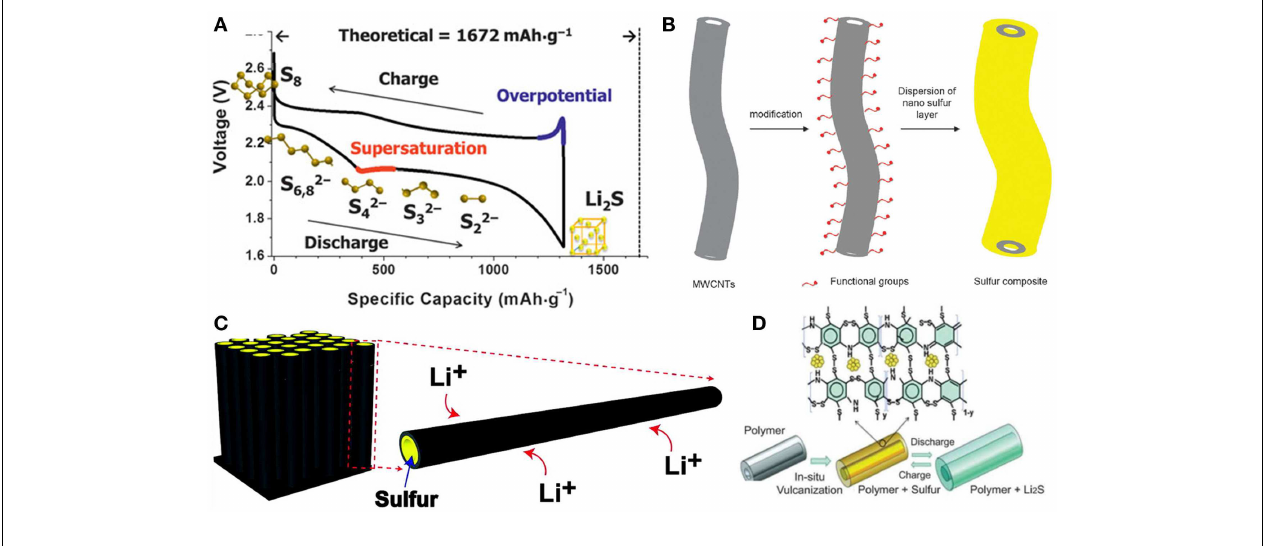
and discharge/charge process of the S-PANI-NT composite (Xiao et al., 2012). Reprinted with permission from Zheng et al. (2011), Chen et al. (2012), Nazar et al. (2014), and Xiao et al. (2012). Copyright 2014 Materials Research Society, 2012The Royal Society of Chemistry, 2011 American Chemical Society, and 2012 JohnWiley & Sons,